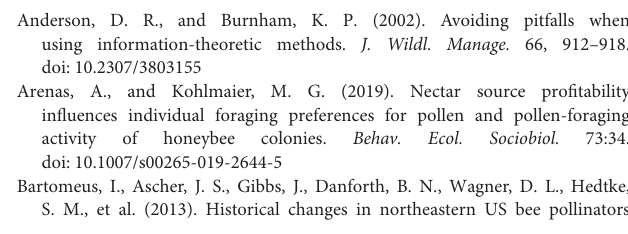
Figure S1 | (A,B) illustrate the sampling scheme, which consistent of two transects ∼ 2m apart, depicted by black arrows, on two rows of squash between two farm types (polyculture and monoculture). Figure S2 | The mean relative abundances ± standard error of (A) squash bees, (B) wild bees, (C) honey bees, and (D) total bees per minute along a 30m transect across the proportion of surrounding agricultural land. Figure S3 | The mean relative abundances ± standard error of (A) squash bees, (B) wild bees, (C) honey bees, and (D) total bees per minute along a 30m transect across early morning (sunrise) and late morning ( ∼